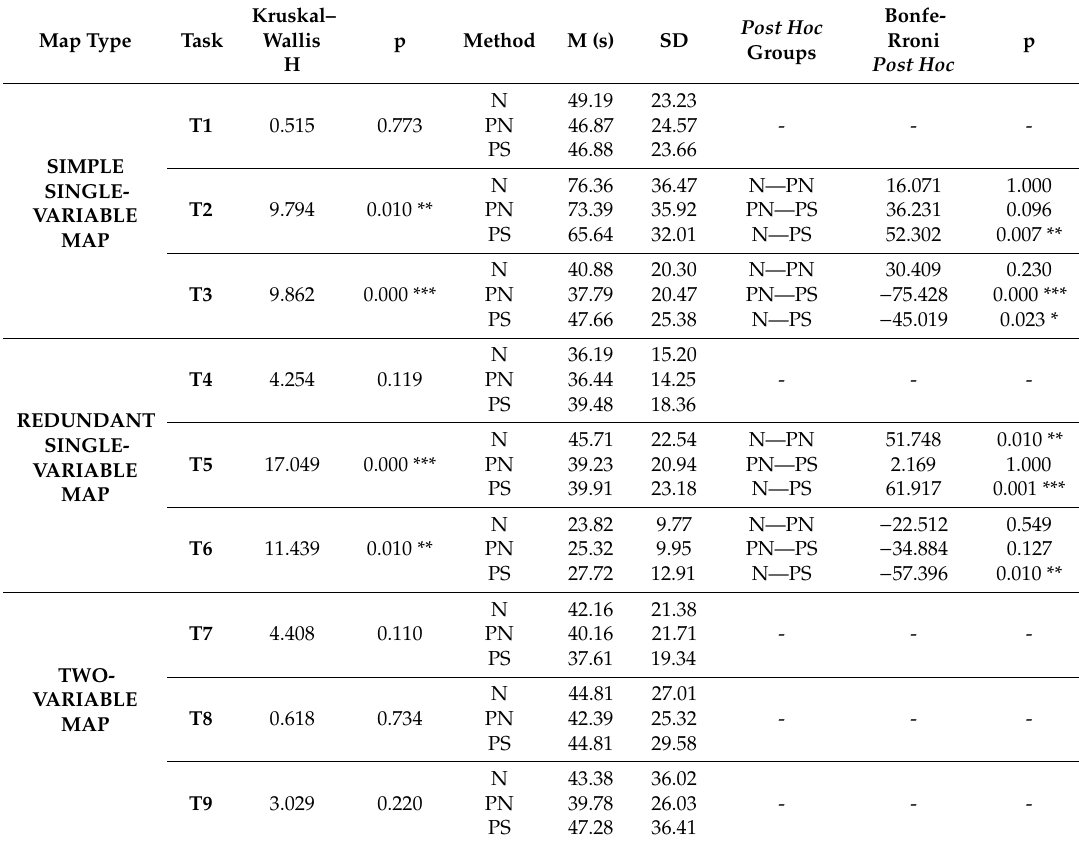
Table 4. Participants’ response times dealing with three types of presentation